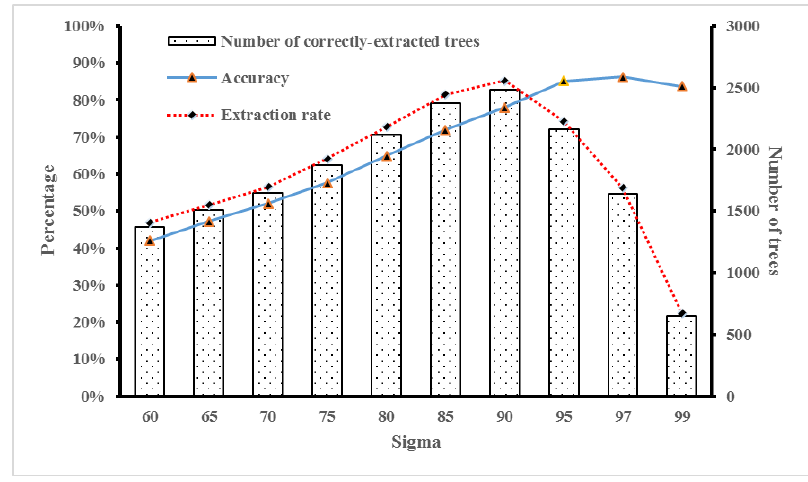
Figure 5. Variation of extraction accuracy with change of Sigma value.